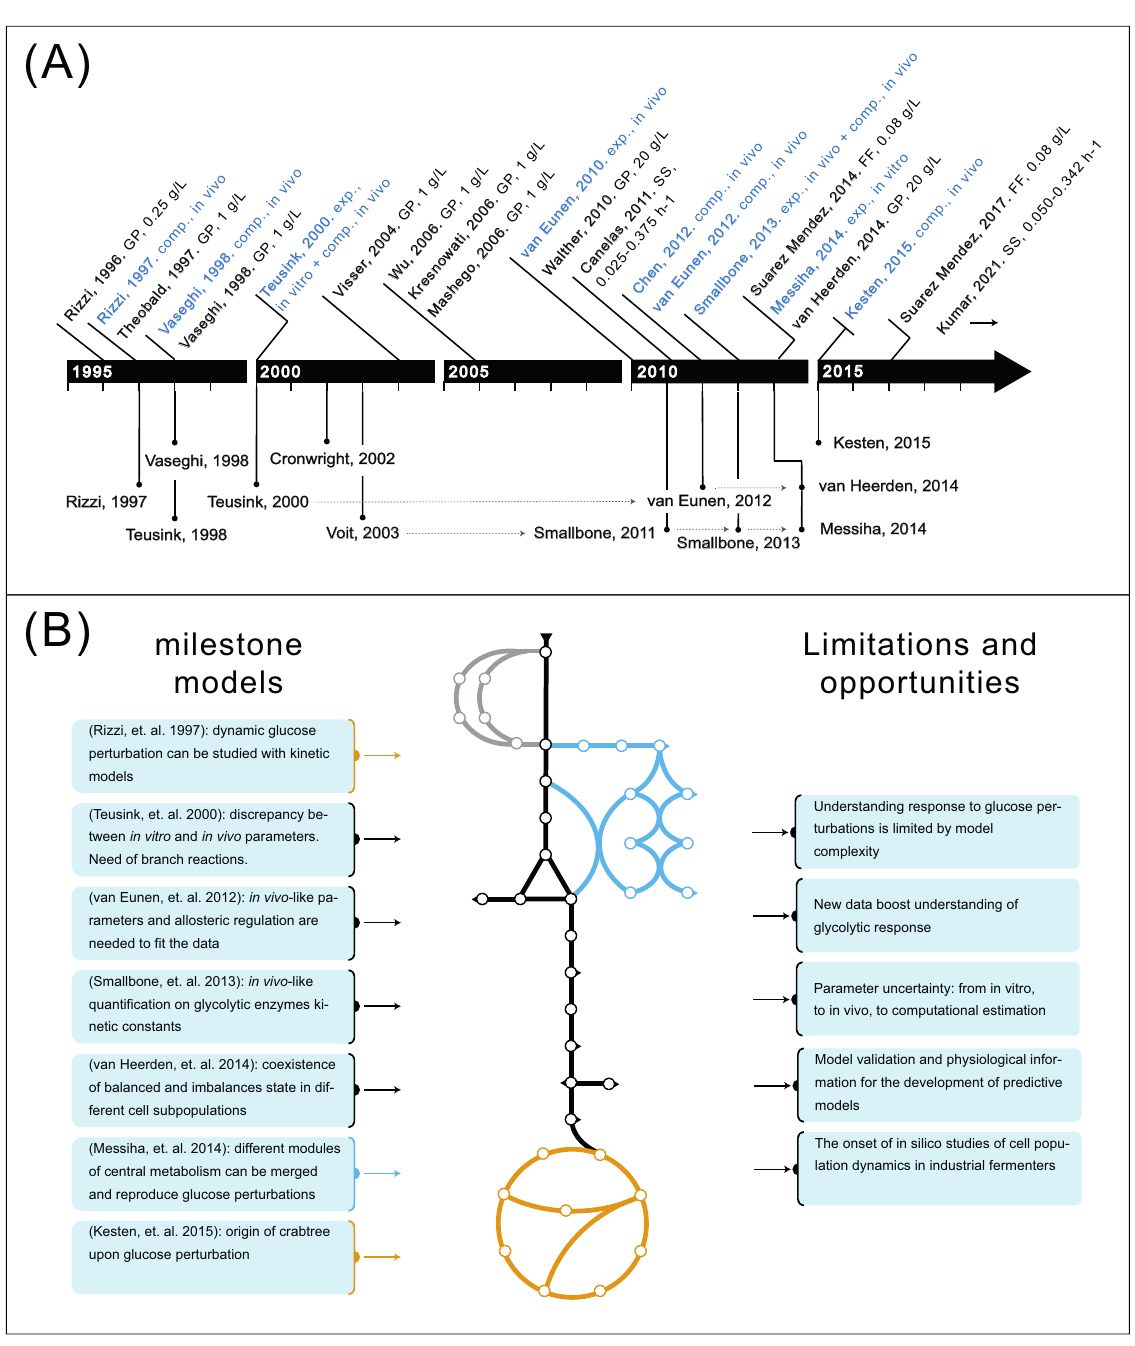
Figure 2. ( A ) A changing field presented by its literature: Above the timeline, from the literature pool of articles obtained in the systematic reviewing process, works which published new data sets are shown. These are displayed in black when the data consisted of intracellular metabolomics or fluxomics and in blue if it consisted of parameter values quantification. Below the timeline, newly developed metabolic models of pathways in central carbon metabolism are displayed. ( B ) ( left ) Contribution of the main models in the field, and ( right ) Limitations and opportunities for research. The simplified representation of CCM displayed in the middle is colored according to the how extensive is the coverage from the models in the left side. A complete trehalose cycle representation coupled to glycolysis (grey) does not exist